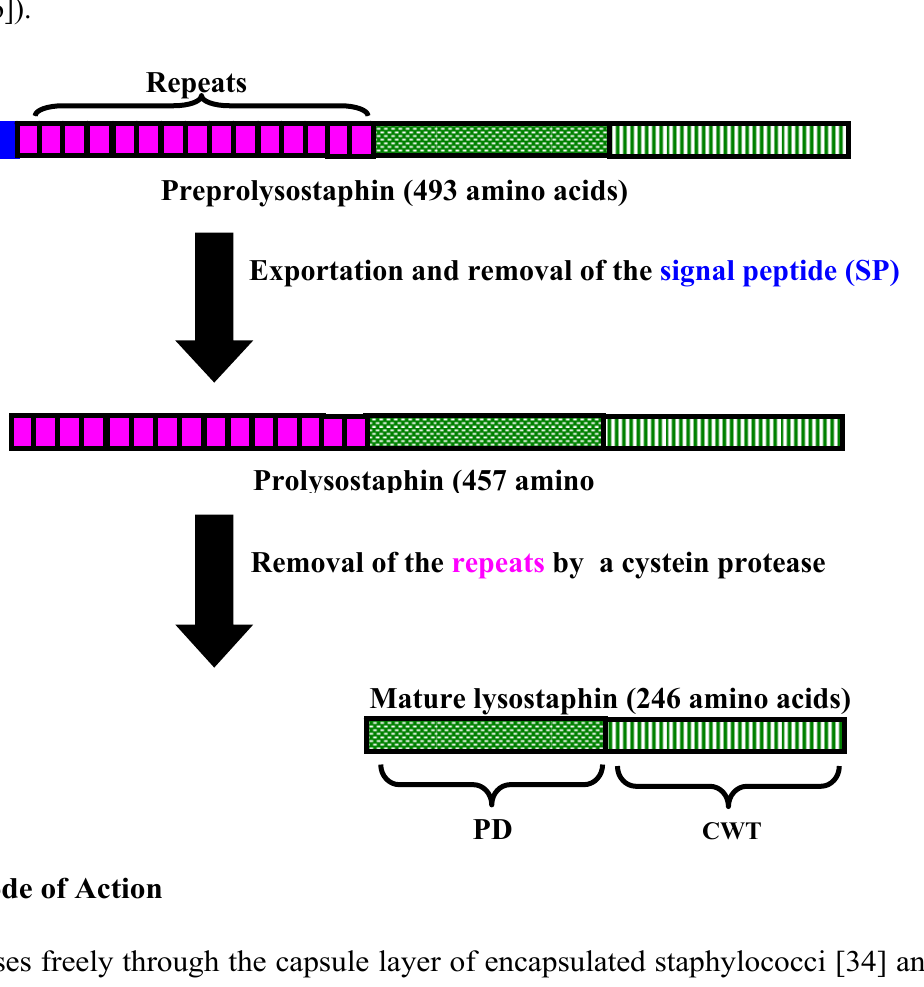
Figure 2. Lysostaphin processing. Lysostaphin is synthesized as a preproenzyme, and after signal peptide removal, soluble prolysostaphin is released into the extracellular medium. Proteolytic cleavage of the propeptide of 211 amino acids, from which 195 residues are organized in 15 tandem repeats of 13-amino acid length, generates the biologically active lysostaphin, which functions as a glycil-glycine endopeptidase against susceptible staphylococcal cells. The lysostaphin molecule consists of two distinct domains: an N- terminal peptidase domain (PD) responsible for its catalytic activity and the C-terminal wall targeting domain (CWT), which directs lysostaphin to its receptor on the